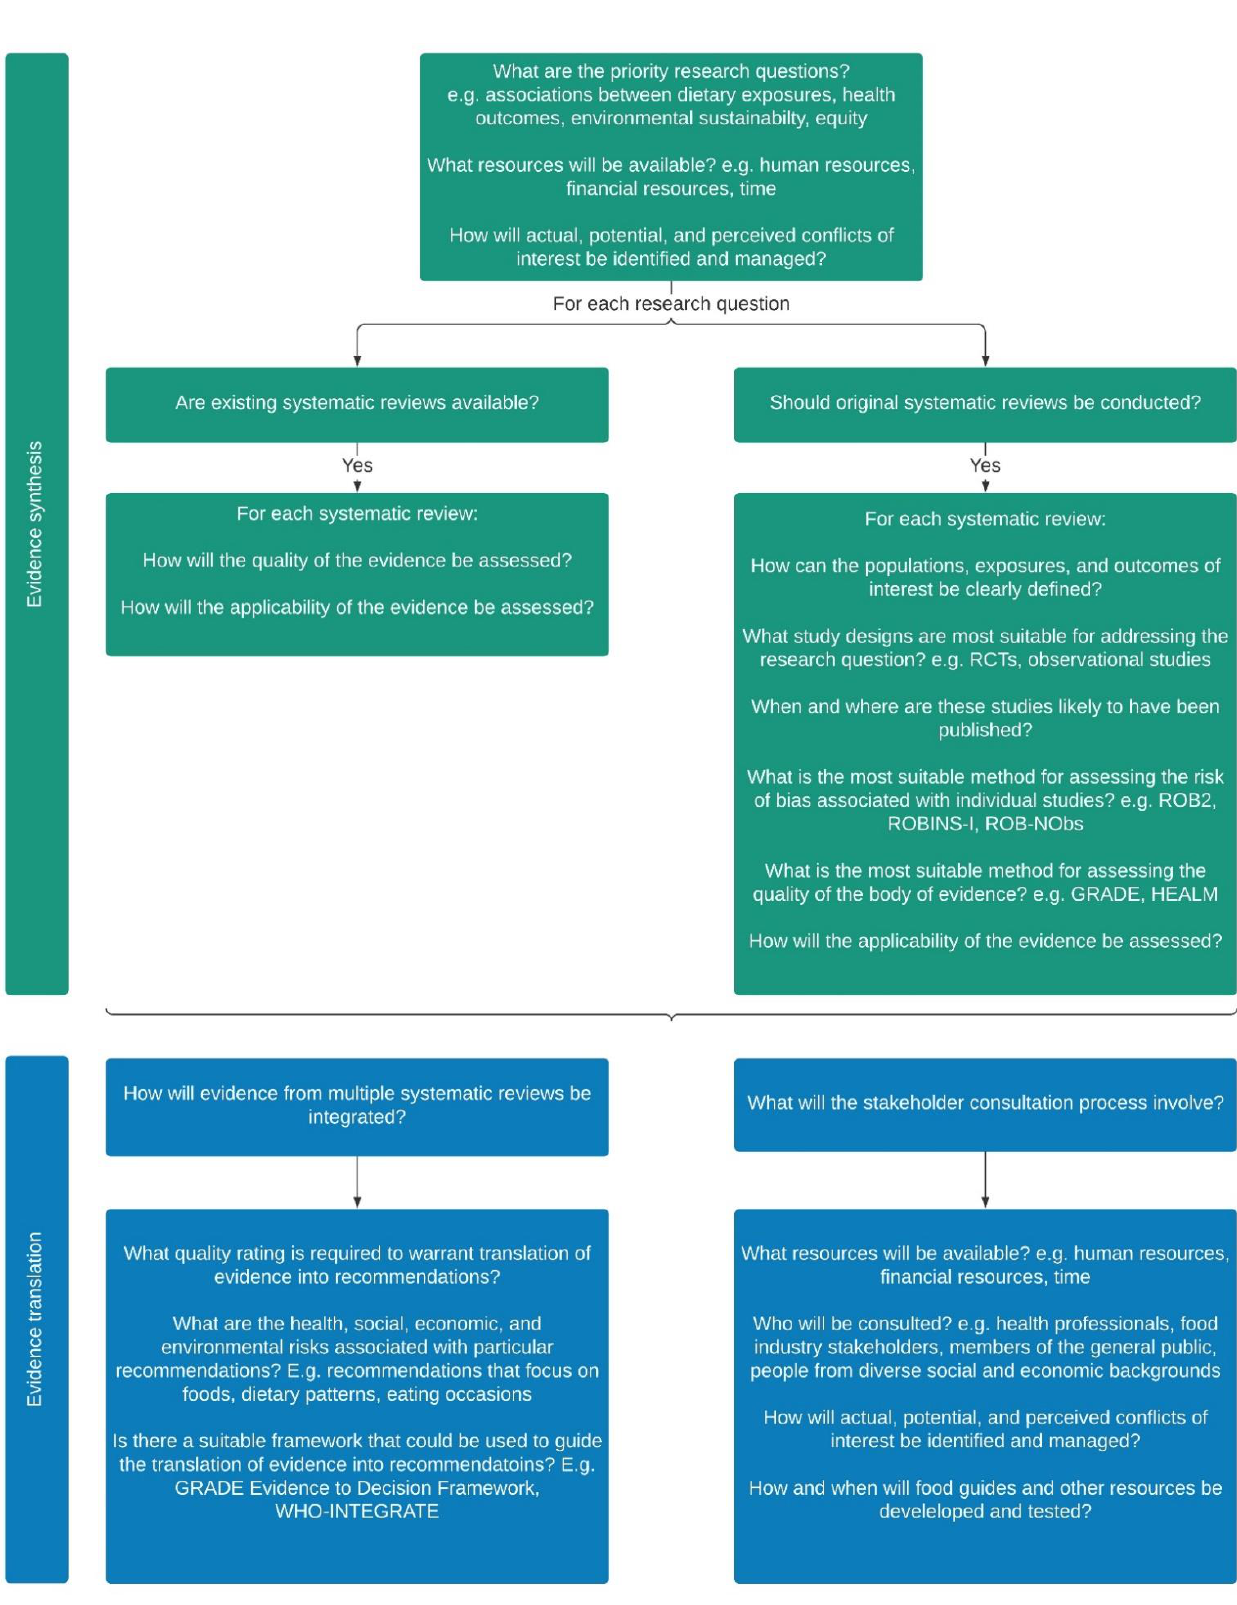
Figure 2. An overview of the practicalities associated with evidence synthesis and translation in dietary guideline devel- opment.